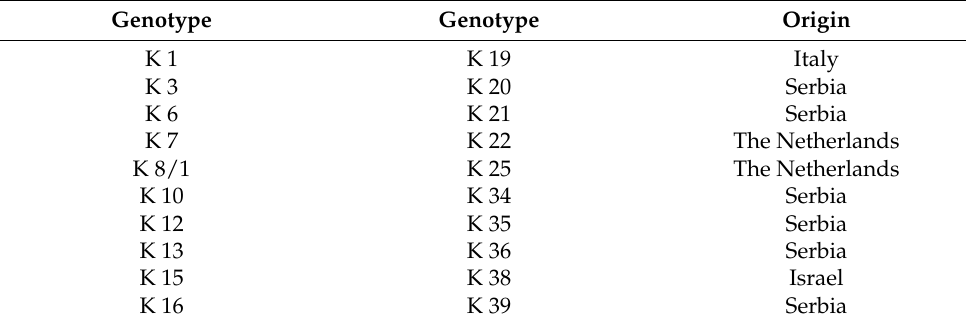
Table 1. The genotypes used and their origins.